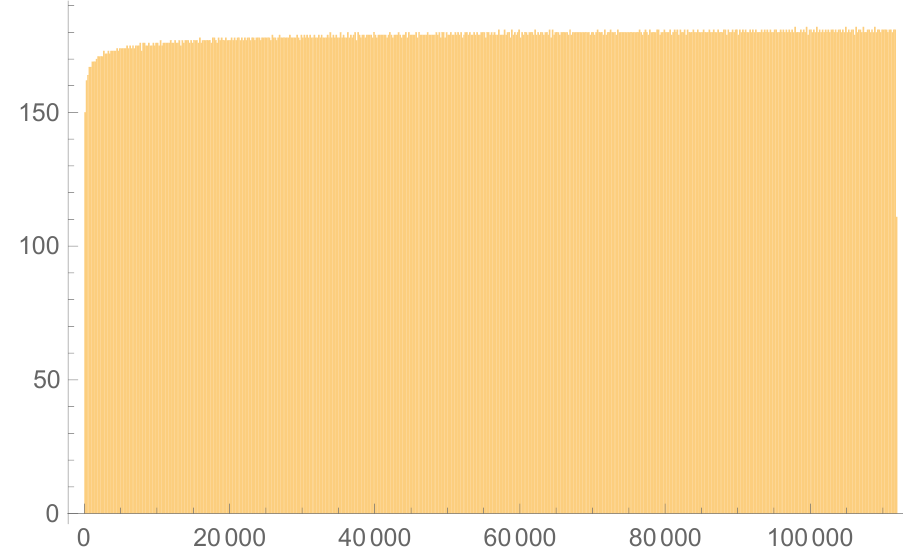
Figure 10 . Density of states for the (cid:12)rst 100000 zeroes. This is very close to be a constant.